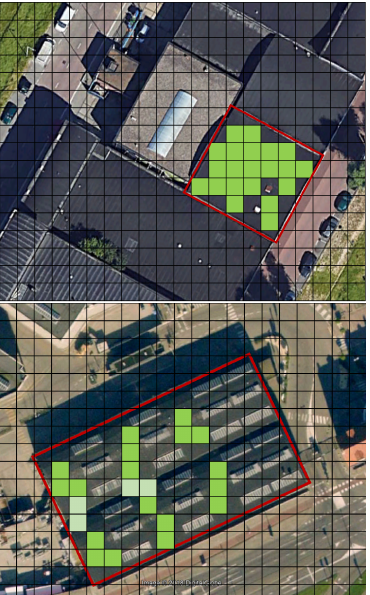
Figure 2. While the majority filter might work for the building on the top (among the pixels contained in the red polygon, only two are containing spectral variations - in this case chimneys), it is rather unlikely to work in situations with a high share of pixels containing spectral variations such as on the bottom (green: ‘clean’ pixels containing a single material, light green: ‘clean’ pixels located in shadow and thus only usable separately).